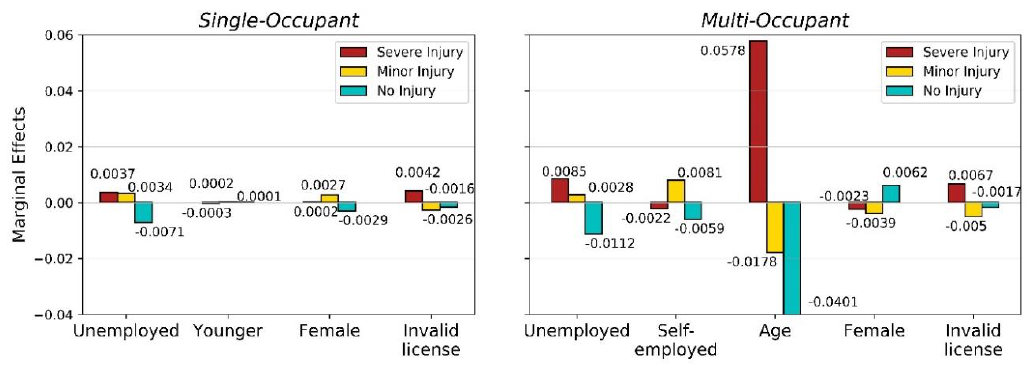
Figure 5. Estimated marginal effects of Driver Characteristics.